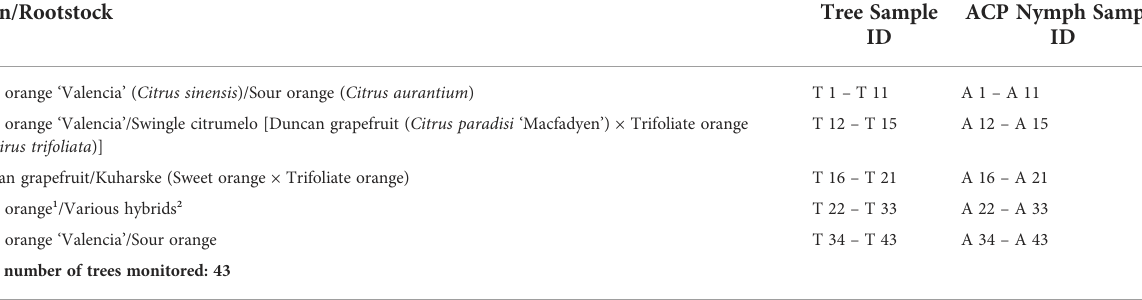
TABLE 2 Description of citrus tree and Asian citrus psyllid ( Diaphorina citri ; ACP) samples included in citrus tristeza virus (CTV) comparative study from Collier County, Florida.